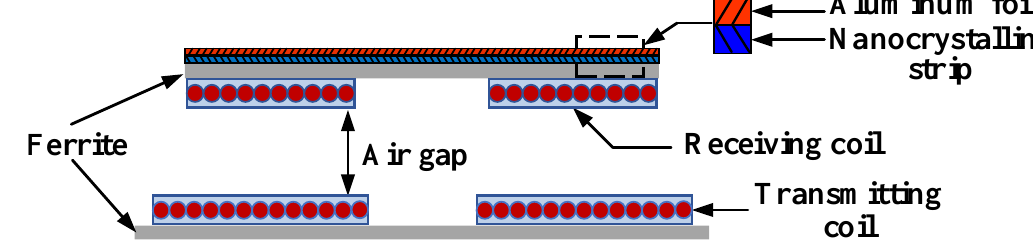
Figure 4. Cross-section view of composite shield magnetic coupler of WPT system.